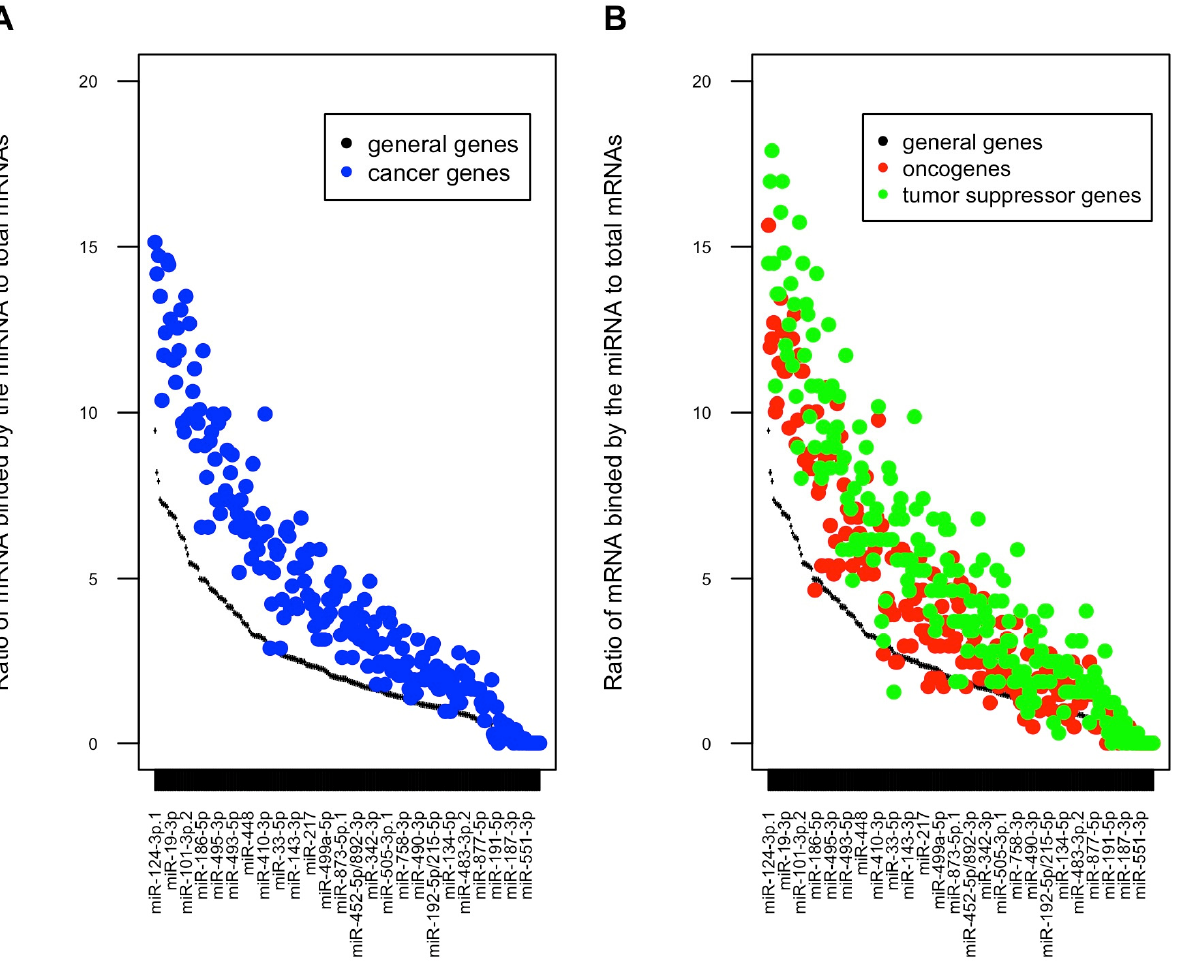
Figure 4. Ratio/Proportion of cancer genes ( A ), and TSGs/oncogenes ( B ) targeted by individual miRNAs as predicted in TargetScan 7.1 database.